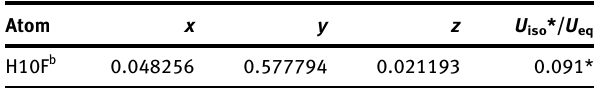
Table  : Fractional atomic coordinates and isotropic or equivalent isotropic displacement parameters (Å 